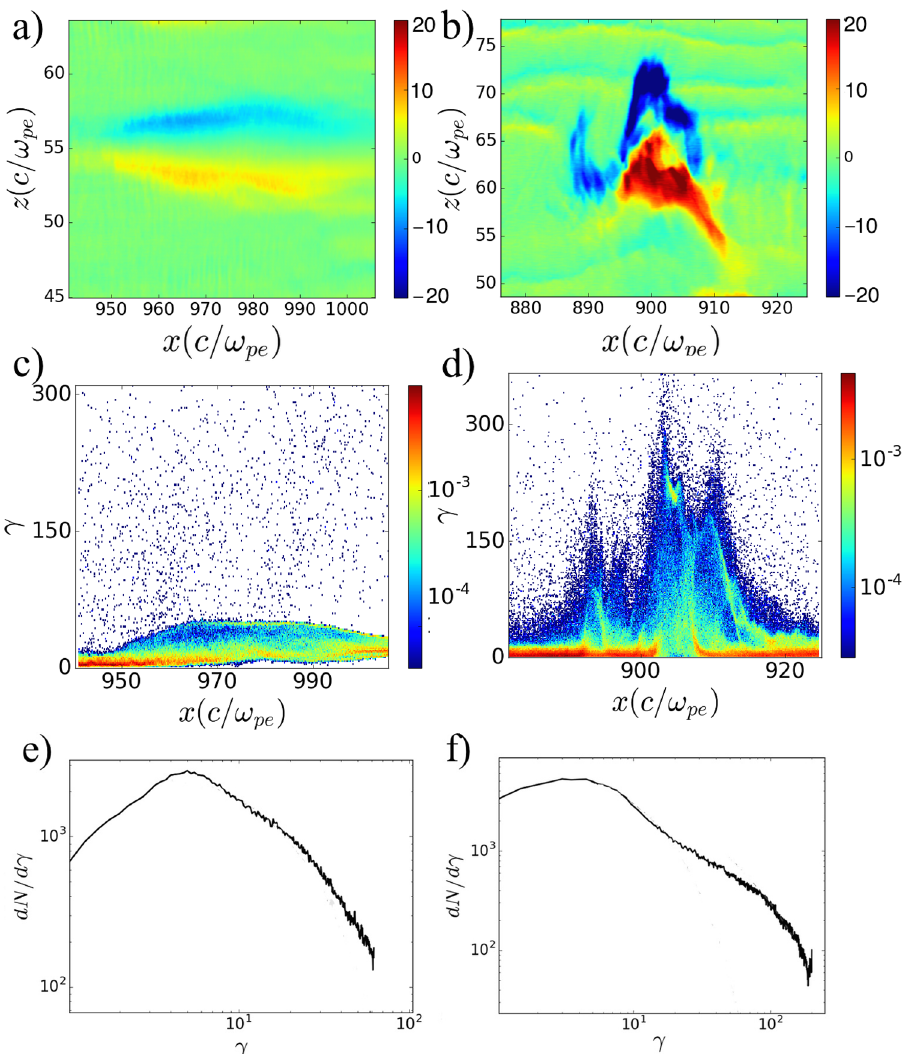
1038 and 1178. ( c , d ) =